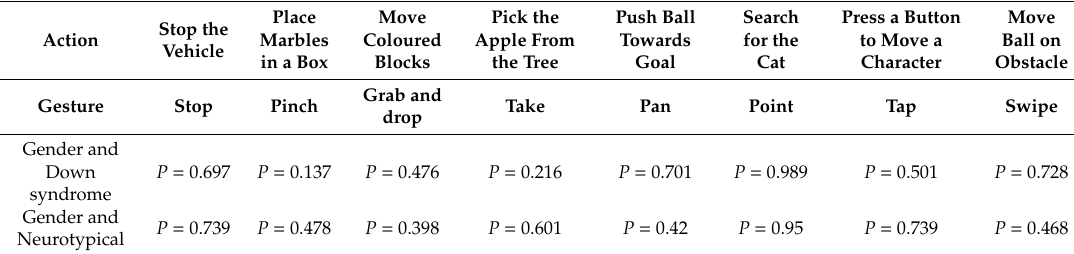
Table 7. Comparison of completion time by gender.